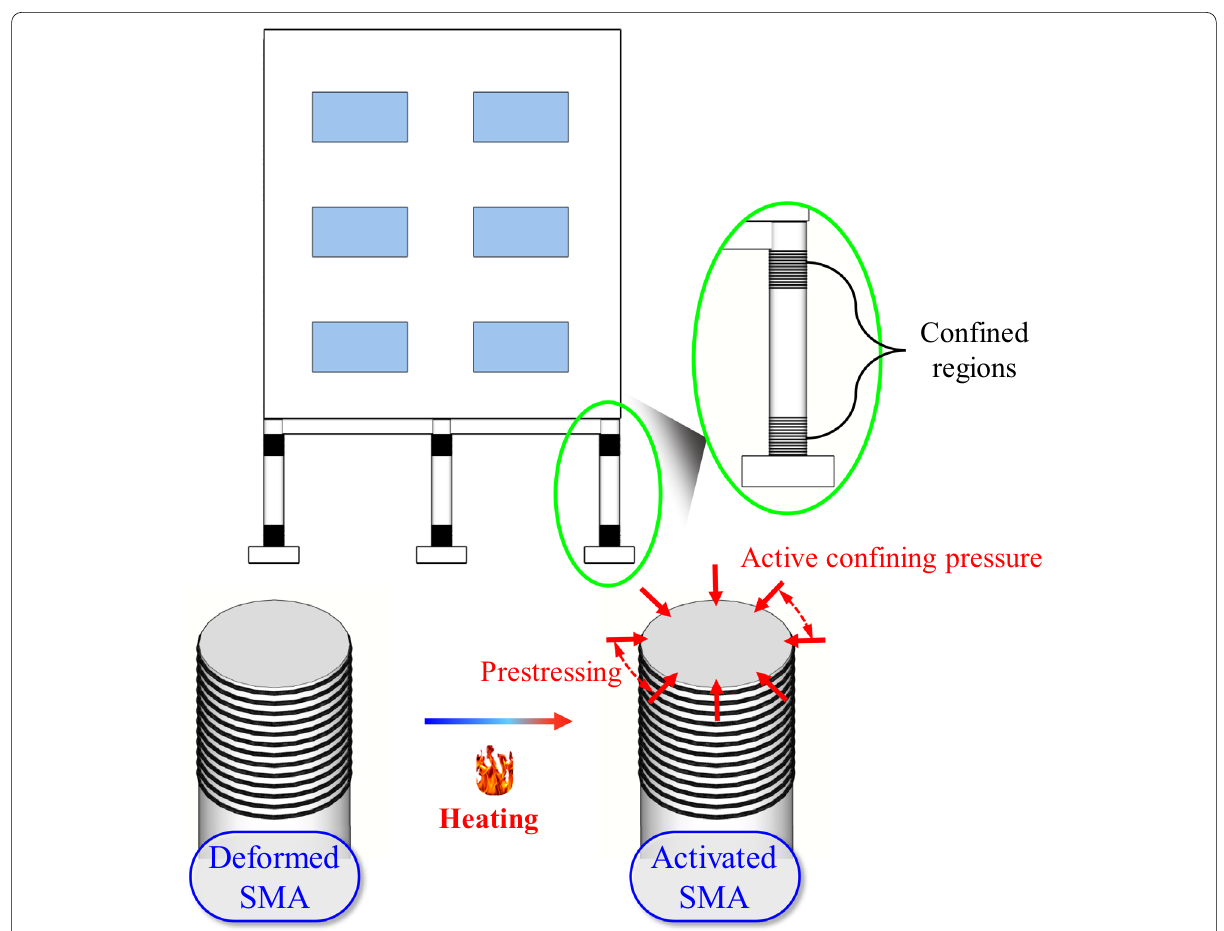
Fig. 3 Schematic of the concept of using SMAs to apply active confinement on RC columns